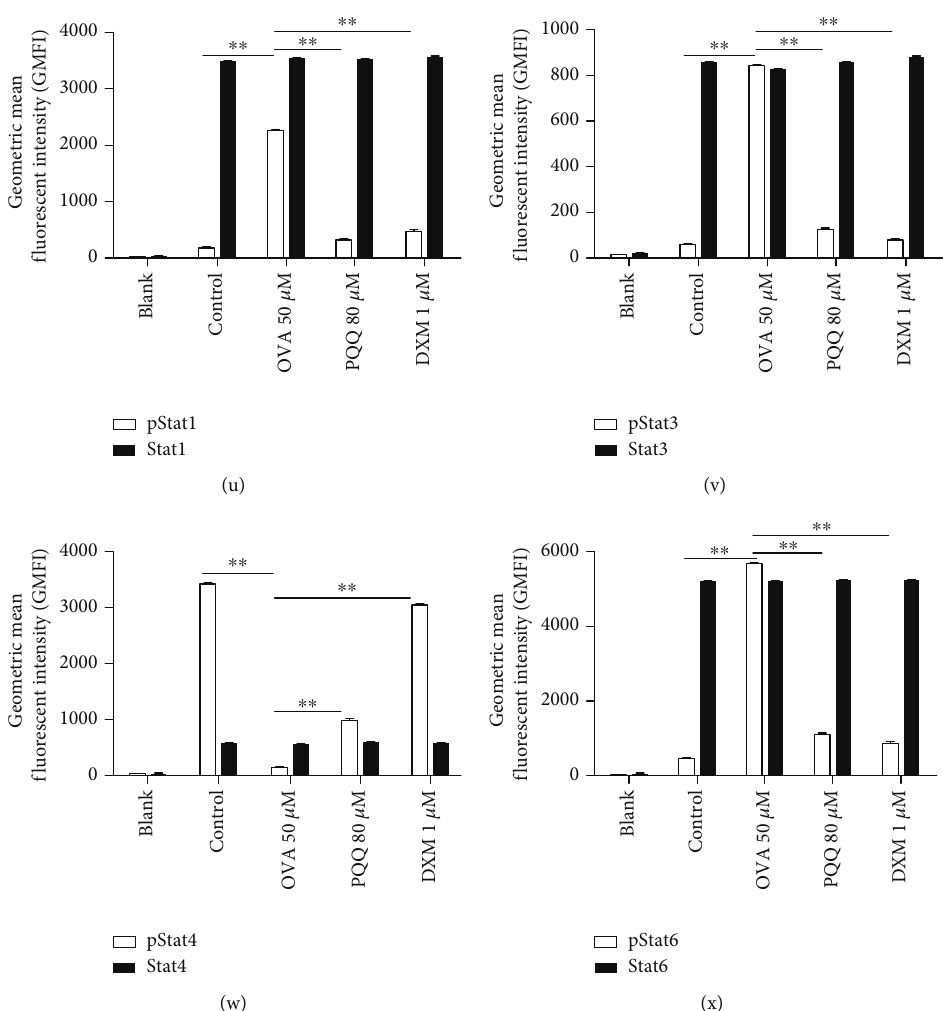
Figure 6: E ff ects of PQQ treatment on the pSTAT1, pSTAT3, pSTAT4, and pSTAT6 signaling pathways in lung tissue and T cells. The phosphorylated STAT1, STAT3, STAT4, and STAT6 levels in lung tissue (a – d), in T cells (M-P), and STAT1, STAT3, STAT4, and STAT6 levels in lung tissue (e – h) and in T cells (Q-T), which are presented as the geometric mean fl uorescent intensity (GMFI) values measured by fl ow cytometry (colored lines). The gray peak is the geometric mean fl uorescence intensity of the blank control. The quantitative analysis of the phosphorylated and total STAT proteins in mouse lung tissue (i – l) and in T cells (u – x). The columns and error bars represent the means and SEMs ( n = 3 − 5 per group). ∗∗ P < 0 : 01 , ∗ P < 0 : 05 . Similar results were obtained in at least three independent